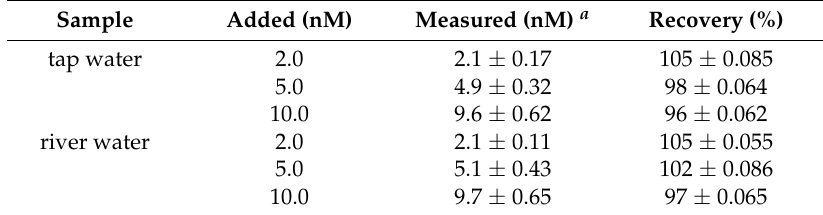
Table 2. Determination of Hg 2+ in water samples with the proposed method.